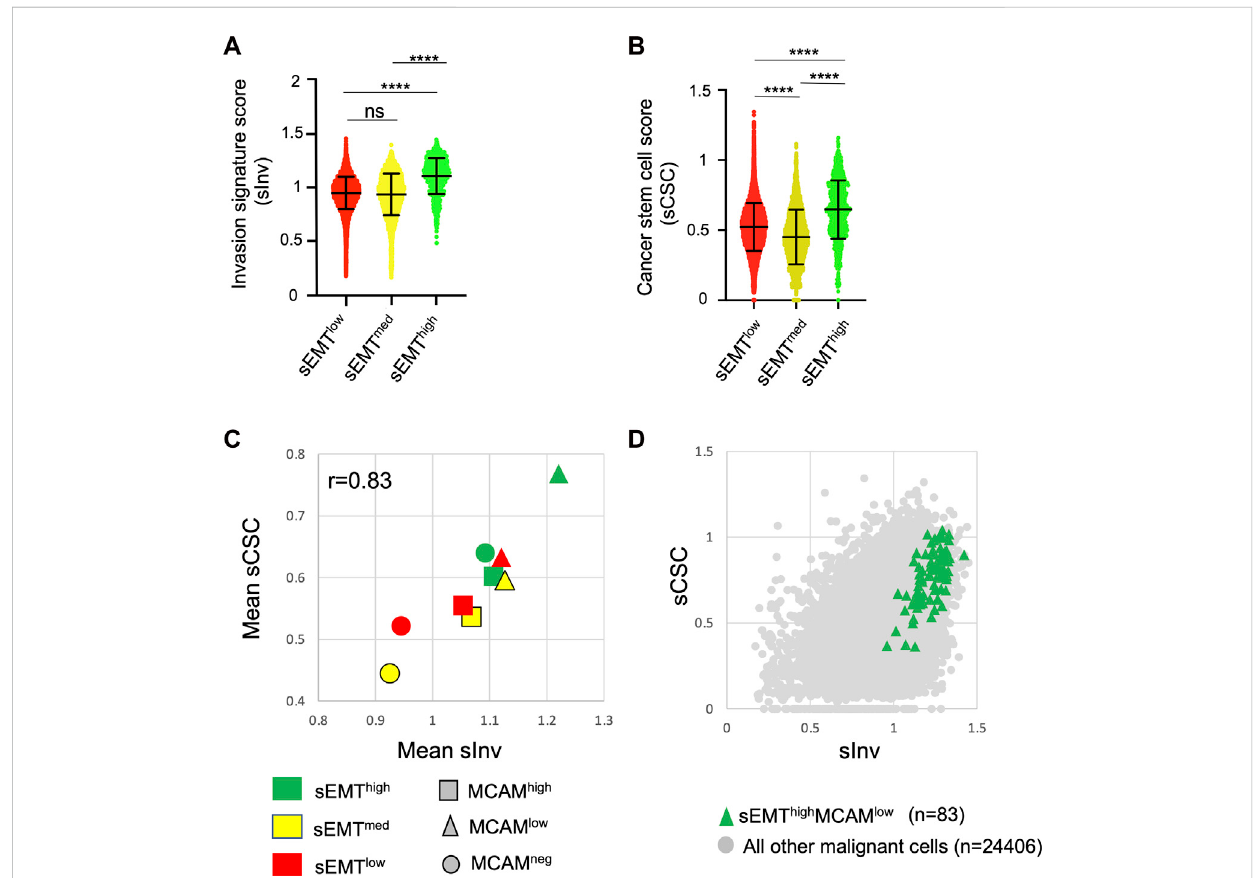
FIGURE 8 Invasive and cancer stem cell phenotypes of MCAM expressing cells. (A) Invasion signature score (sInv) of the sEMT low , sEMT med and sEMT high populations. (B) Cancer stem cell score (sCSC) of the sEMT low , sEMT med and sEMT high populations. For (A,B) , the graphs show the mean and standard deviation.Statisticalanalysiswasperformedusinganunpaired,two-tailedMannWhitneytest;**** p < 0.0001,nsisnotsigni fi cant. (C) MeansInvandsCSC of the sEMT low , sEMT med and sEMT high populations further sub-divided according to MCAM gene expression. Cells with no detectable MCAM expression were identi fi ed and then MCAM expressing cells were divided into two equal sized groups of MCAM low or MCAM high cells. Spearman ’ s r for the dataisshown. (D) Invasionsignaturescore(sInv)andcancerstemcellscore(sCSC)ofthesEMT high MCAM low sub-population( n =83)comparedtoallother malignant cells ( n =